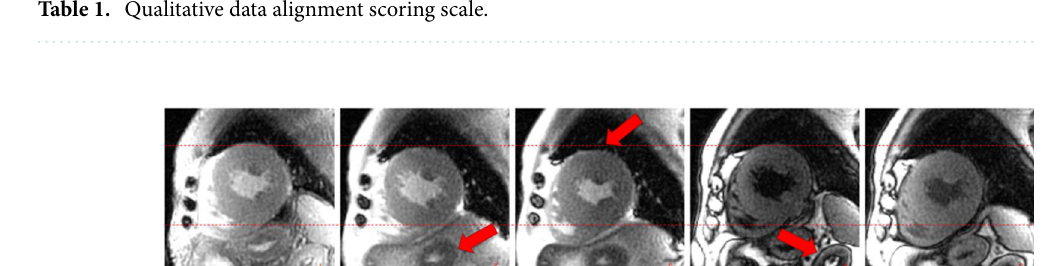
Table 1. Qualitative data alignment scoring scale.